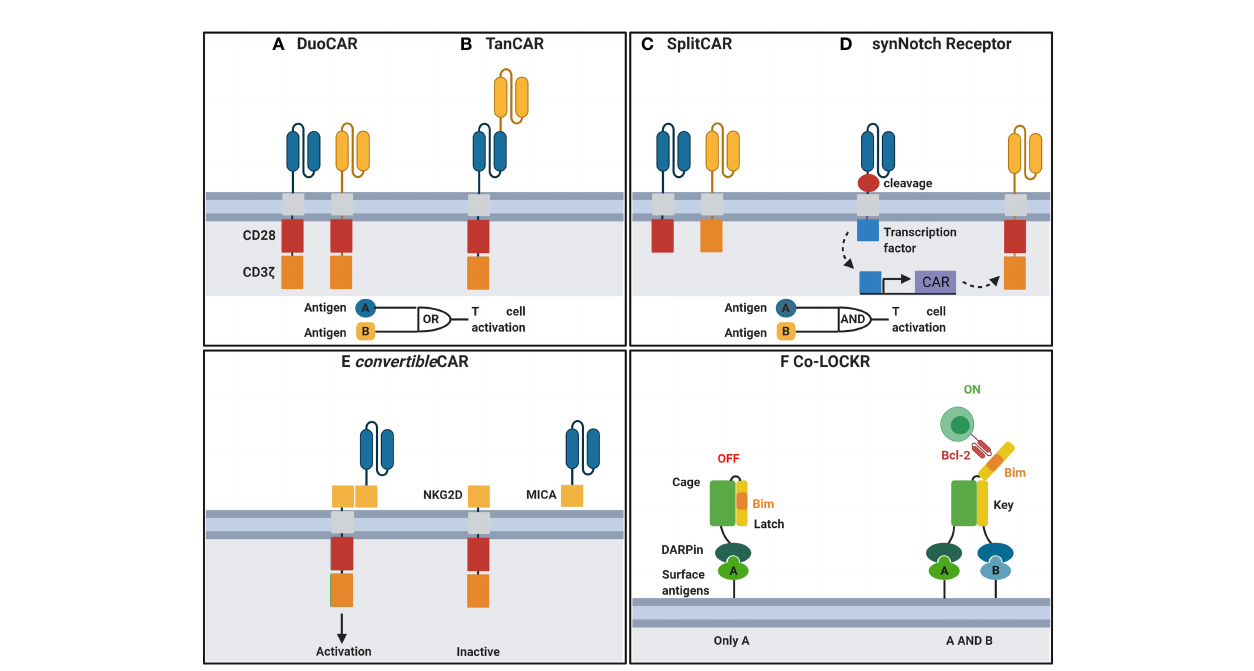
FIGURE 2 | Engineering CAR-T cells for improved function. (A) DuoCARs target independent antigens by CAR co-expression. (B) TanCARs adopt a tandem antigen recognition domain to target multiple antigens. (C) CD3 z and costimulatory domains are split between independent antigen recognition domains in SplitCARs for T cell activation upon recognition of both antigens. (D) Upon recognition of antigen, synNotch receptors undergo transmembrane cleavage and release of their intracellular transcriptional domain which in turn induces the transcription of a secondary CAR for recognition of a second antigen and T cell activation. (E) convertible CAR, a universal system where the antigen-targeting domain and the T cell signalling unit are split. Effector cells express CARs incorporating NKG2D, the natural receptor of the MIC/ULBP ligand family. MicAbody, comprised of the MICA ligand bound to the scFv of an antibody of interest, is administered separately. (F) DARPin linked to a Cage protein bind to surface antigens. Upon binding of a secondary DARPin linked to a key protein to its antigen, the latch is released exposing Bim to bind to a Bcl-2 CAR. CAR, chimeric antigen receptor; NKG2D, MICA receptor; MICA, NKG2D ligand; DARPin, designer ankyrin repeat proteins. Created with BioRender. Adapted from Guedan et al.